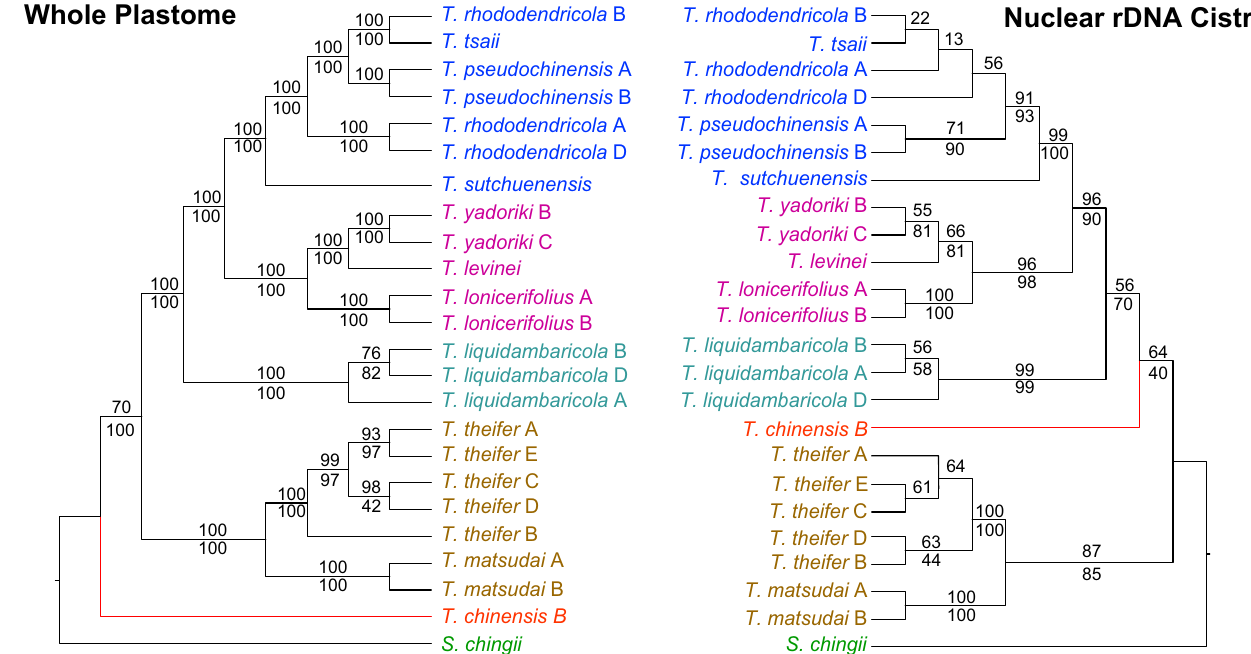
Fig 2. Comparison of plastome and nuclear rDNA ML gene trees for Taxillus species. A. ML tree derived from an analysis of the whole plastome dataset. This tree is generally congruent with the one obtained from mitochondrial rDNA sequences. The Maximum Likelihood Bootstrap values (MLBS) and Maximum Parsimony Bootstrap (MPBS) values are indicated above and below the branches, respectively. B. Tree inferred from the ML analysis of the nuclear rDNA sequences. MLBS and MPBS values are indicated above and below the branches, respectively.